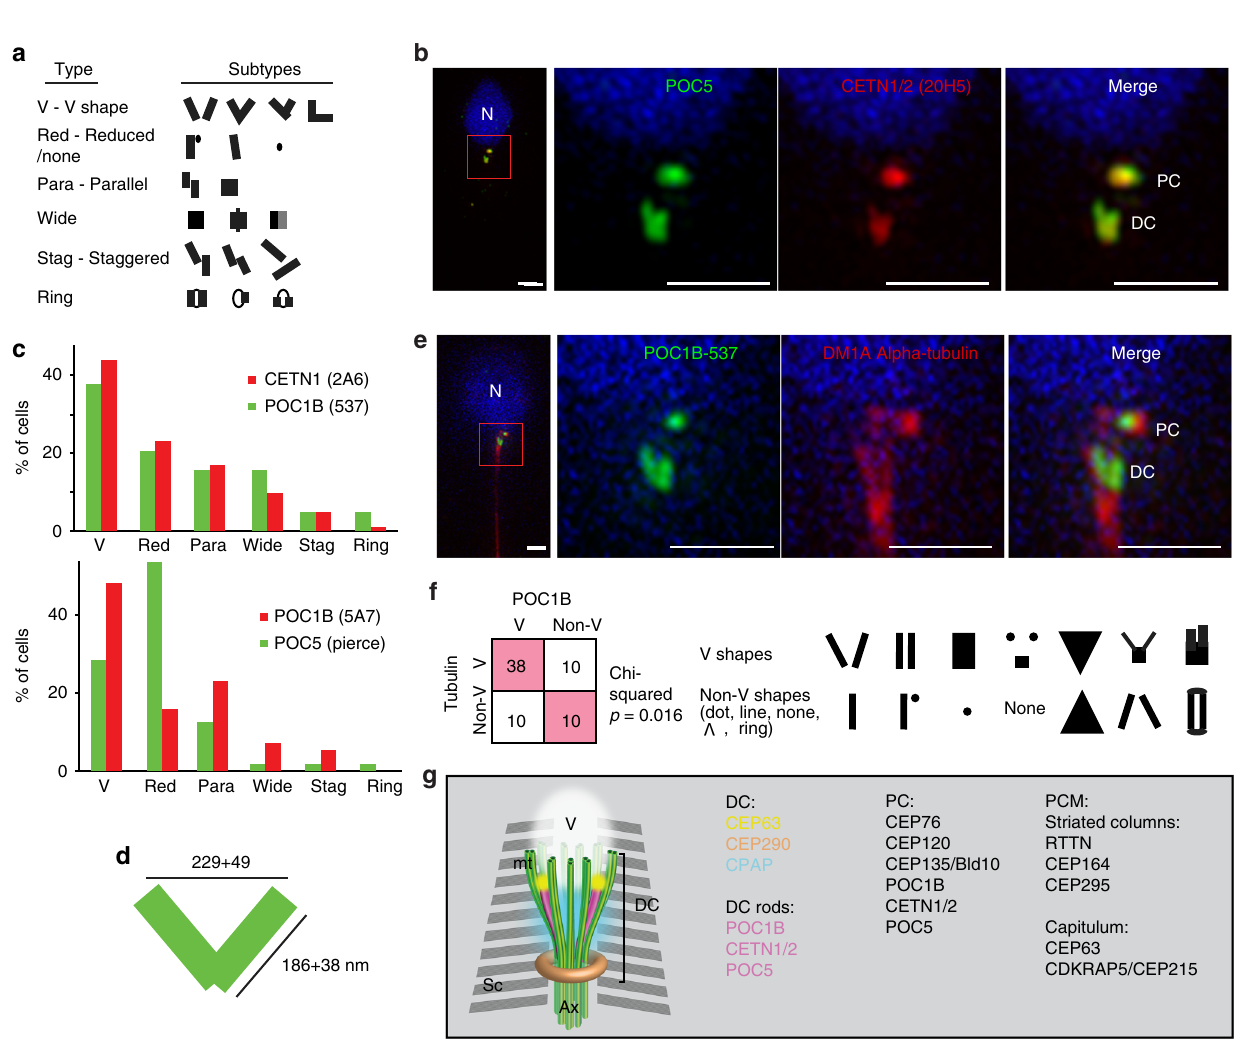
Fig. 3 The precise location of DC proteins. a Diagrams of the six types of DC rods morphologies. b 3D-SIM showed “ V ” -shaped rods of centriolar proteins POC5 and CETN1/2. c Graph depicting the abundance of the six types of DC rods morphologies. The most common type for both CETN1/2 and POC1B is “ V ” shape (N~140). POC5 shows both a high rate of “ V ” shape (~25%), and a higher rate of “ reduced ” shape. d A diagram depicting the dimensions of the rods (height and width) and their distances from each other (from center to center of the rods) at their tips and bases ( N ≥ 20). e 3D-SIM showed “ V ” - shaped rods of centriolar protein POC1B fl anking the splayed microtubules shown with DM1A, α -tubulin (red). f Quanti fi cation of the relationship between POC1B shape and tubulin shape in 3D-SIM. Most cells that have “ V ” -shaped tubulin also have “ V ” -shaped POC1B, suggesting that their morphology correlates. p = 0.016 by Chi-squared. g Model of the DC in the ejaculated spermatozoon based on electron microscopy, confocal microscopy, and 3D-SIM. Sc striated columns, Ax axoneme, V vault. Scale bars 1 μ